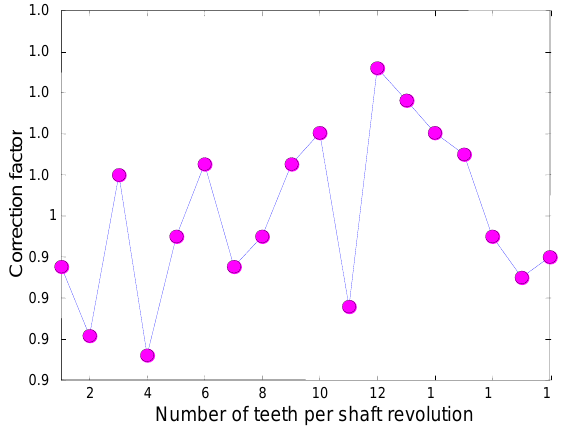
Figure 5. Unique set of compensation factors through the search of N complete shaft